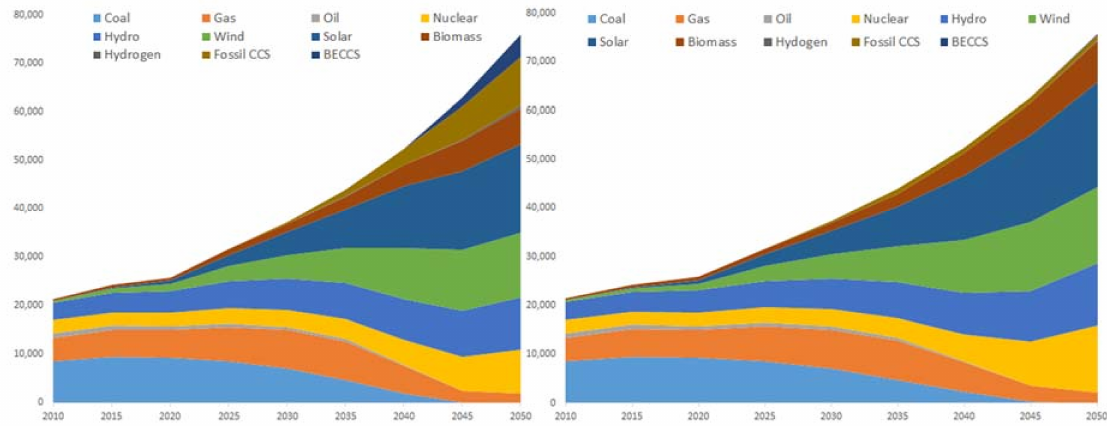
Figure 6. Global electricity production by technology over 2010–2050 (in